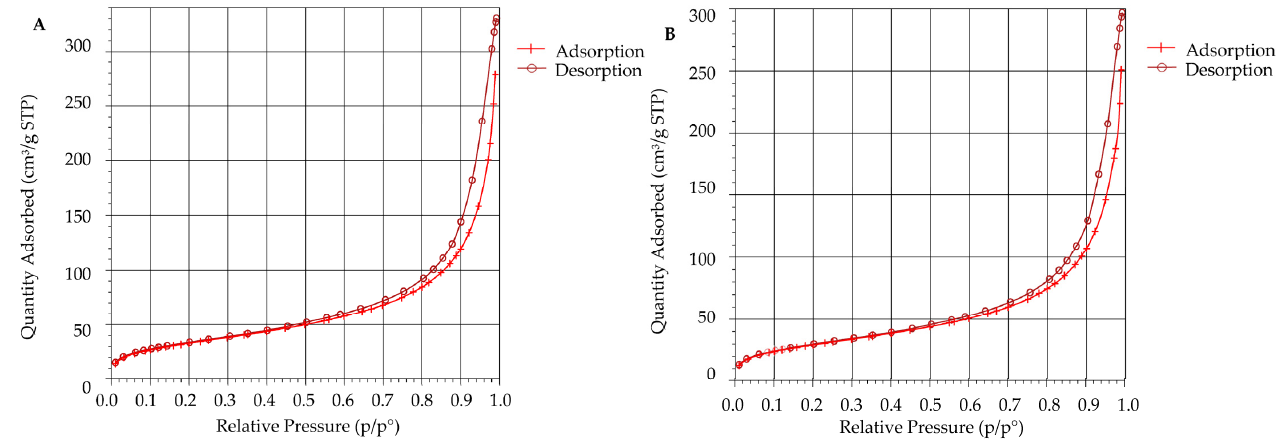
Figure 7. Nitrogen adsorption-desorption isotherm plots of Seplite LX120, before ( A ) and after ( B ) immobilization of carboxylic acid reductase from Mycobacterium phlei ( Mp CAR).